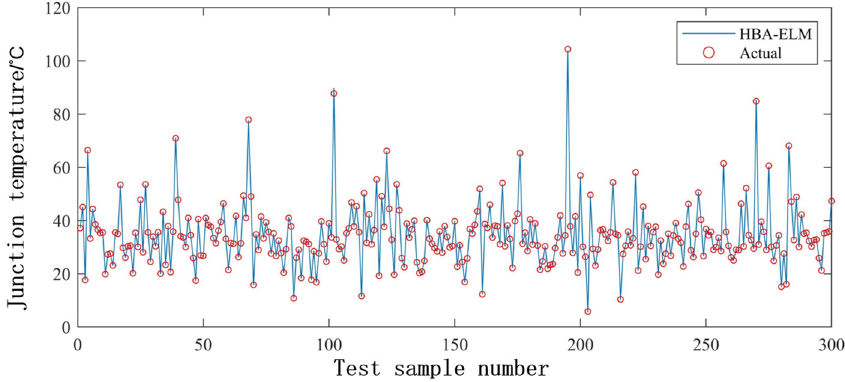
Figure 8. Predicted junction temperature of the HBA-ELM model.